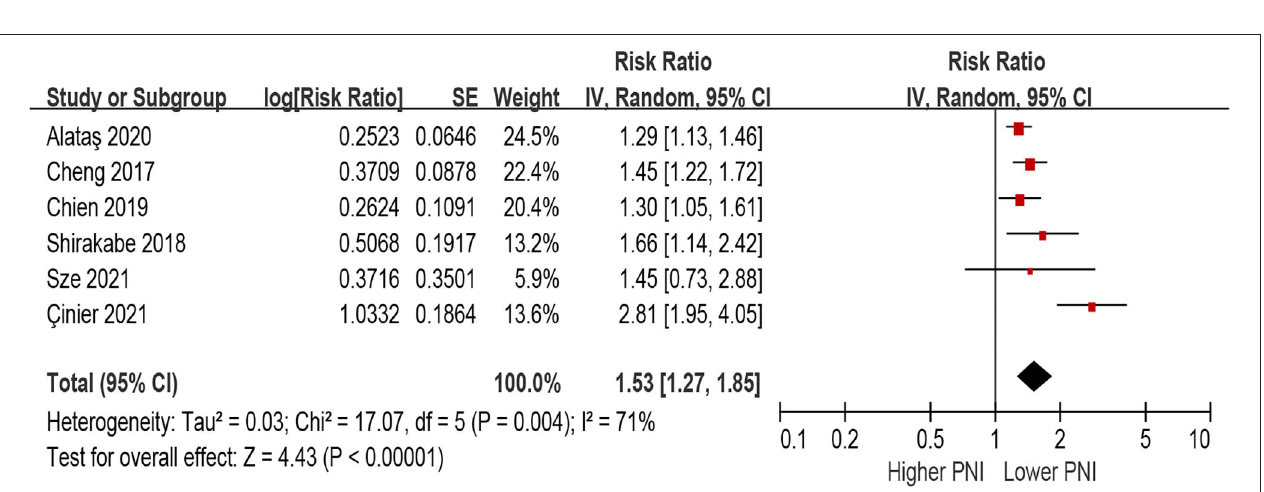
FIGURE 2 | The association between PNI (defined as lower vs. higher) and the risk of all-cause mortality in HF (unadjusted model). CI, confidence interval; HF, heart failure; PNI, prognostic nutritional index.